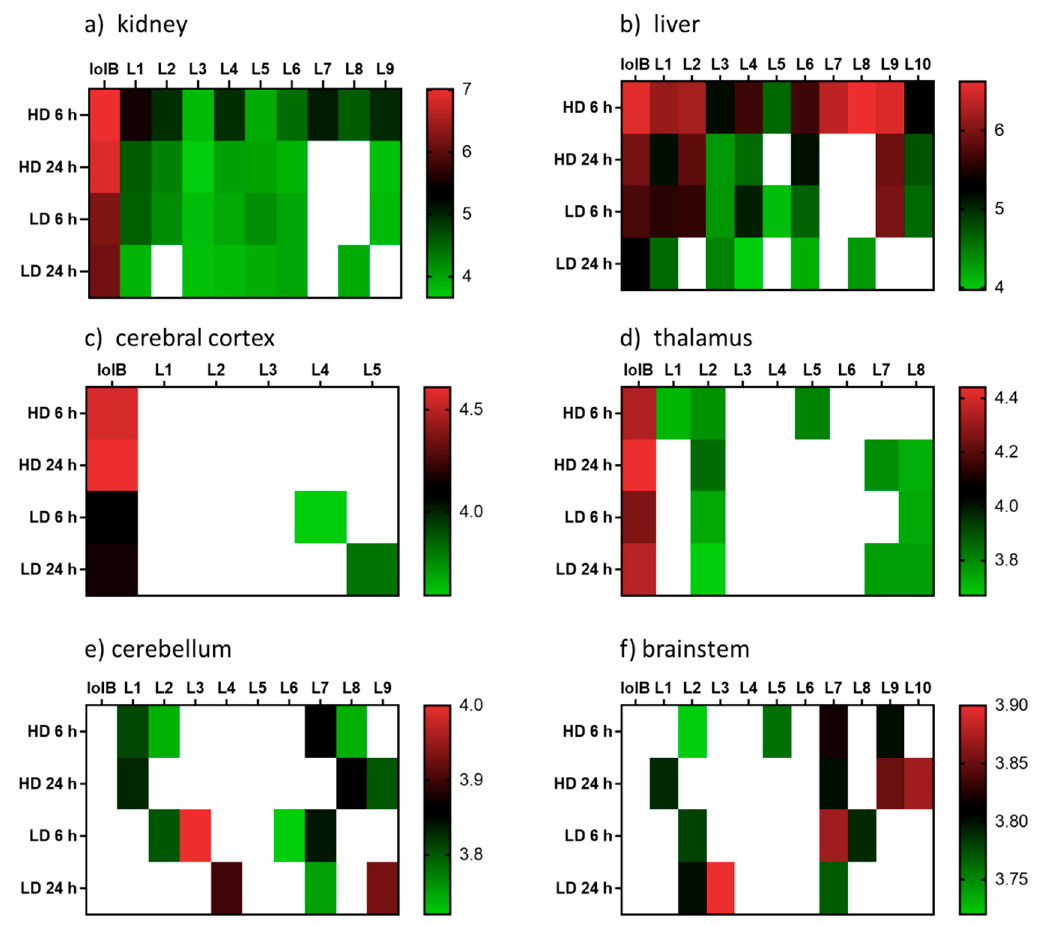
Figure 3. Heatmap displaying the relative abundances (log10 transformed) of lolitrem B biotransformation products distributed in the body: ( a ) kidney ( b ) liver and brain tissue: ( c ) cerebral cortex ( d ) thalamus ( e ) cerebellum ( f ) brainstem of mice exposed to lolitrem B at high dose (HD) (2.0 mg / kg b.wt) and low dose (LD) (0.5 mg / kg b.wt) at time points 6 h and 24 h post treatment. L1 ( m / z 702.4014) and L2 ( m / z 702.3971) were the result of lolitrem B hydroxylation ( + O)